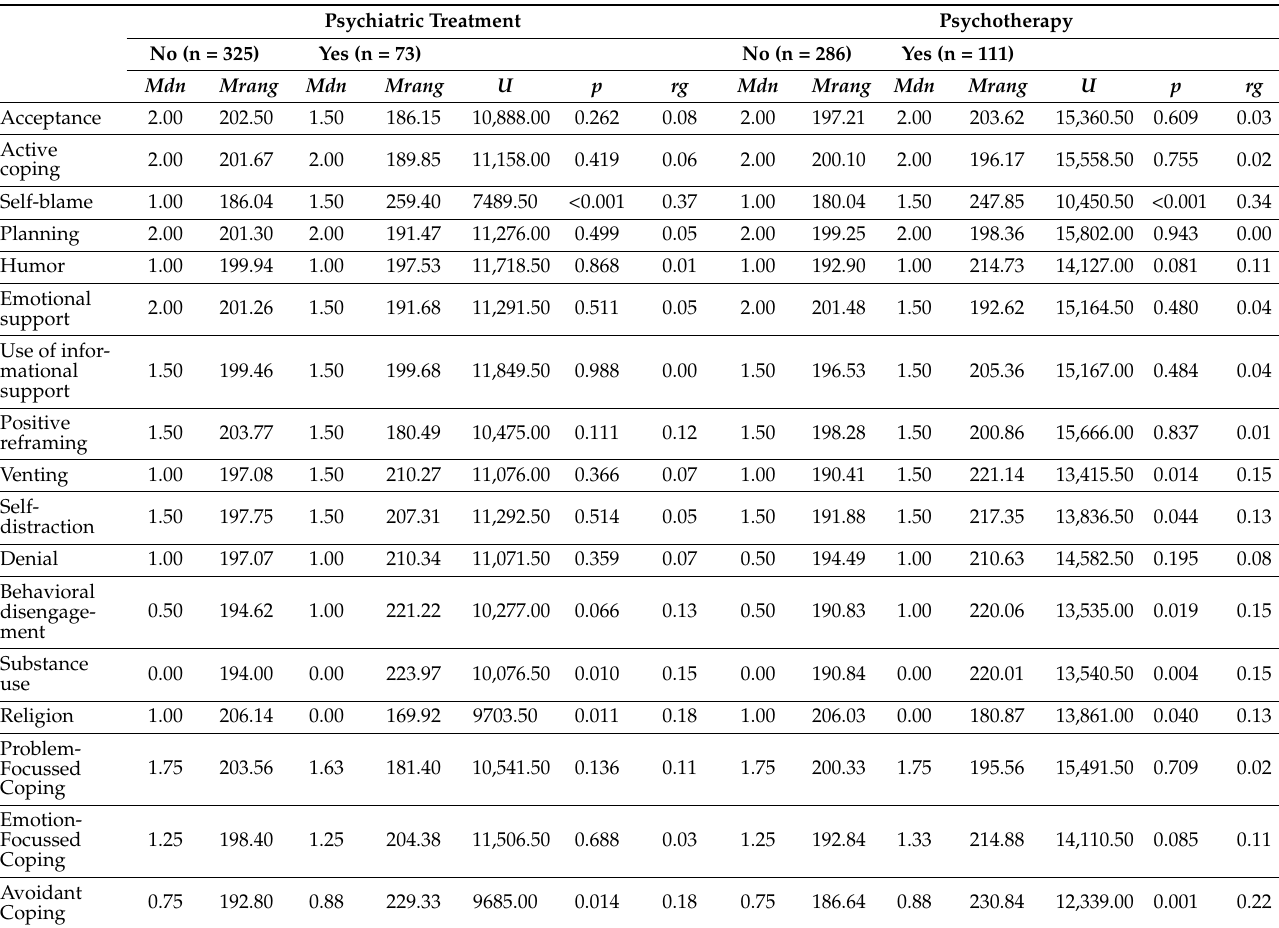
Table 4. Coping strategies in relation to previous psychiatric treatment and